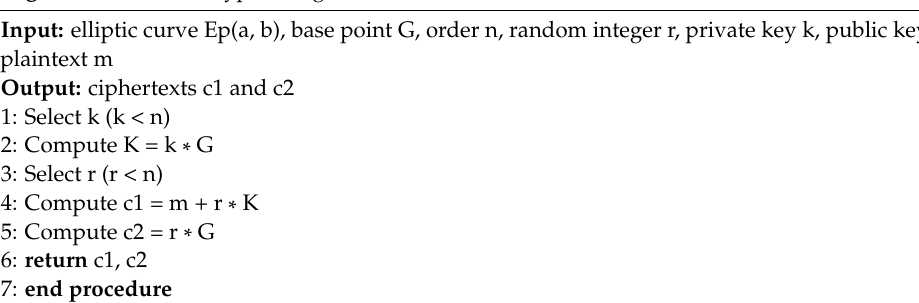
Algorithm 2 ECC encryption